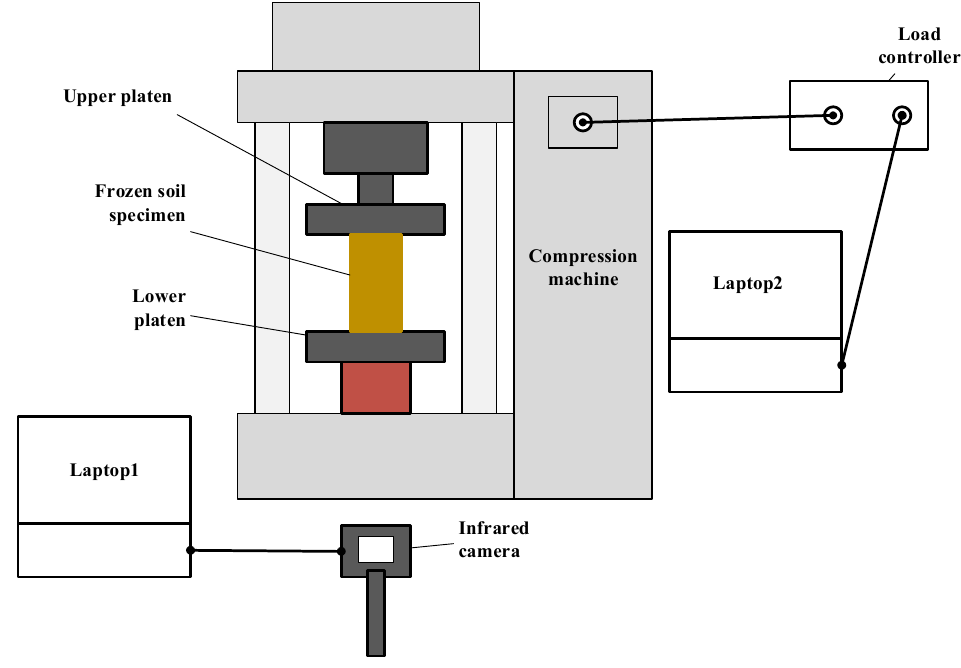
Figure 3. Experimental apparatus setup.